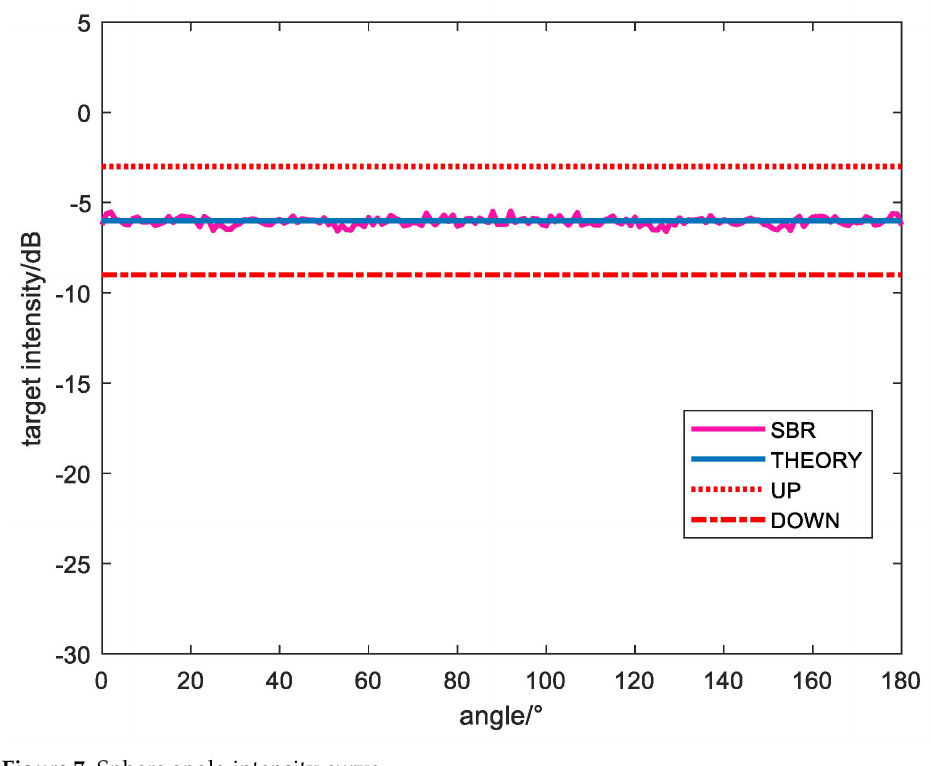
Figure 7. Sphere angle-intensity curve.